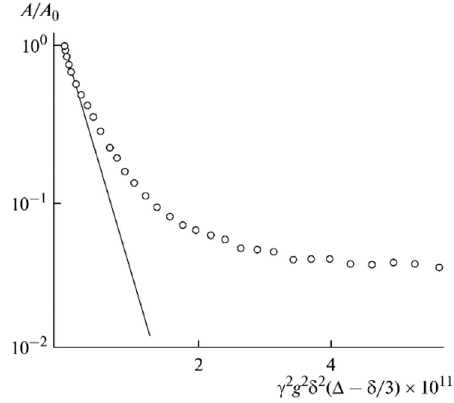
Figure 11. Example of 1 H diffusion decay in PGE sample no. 7 [53].